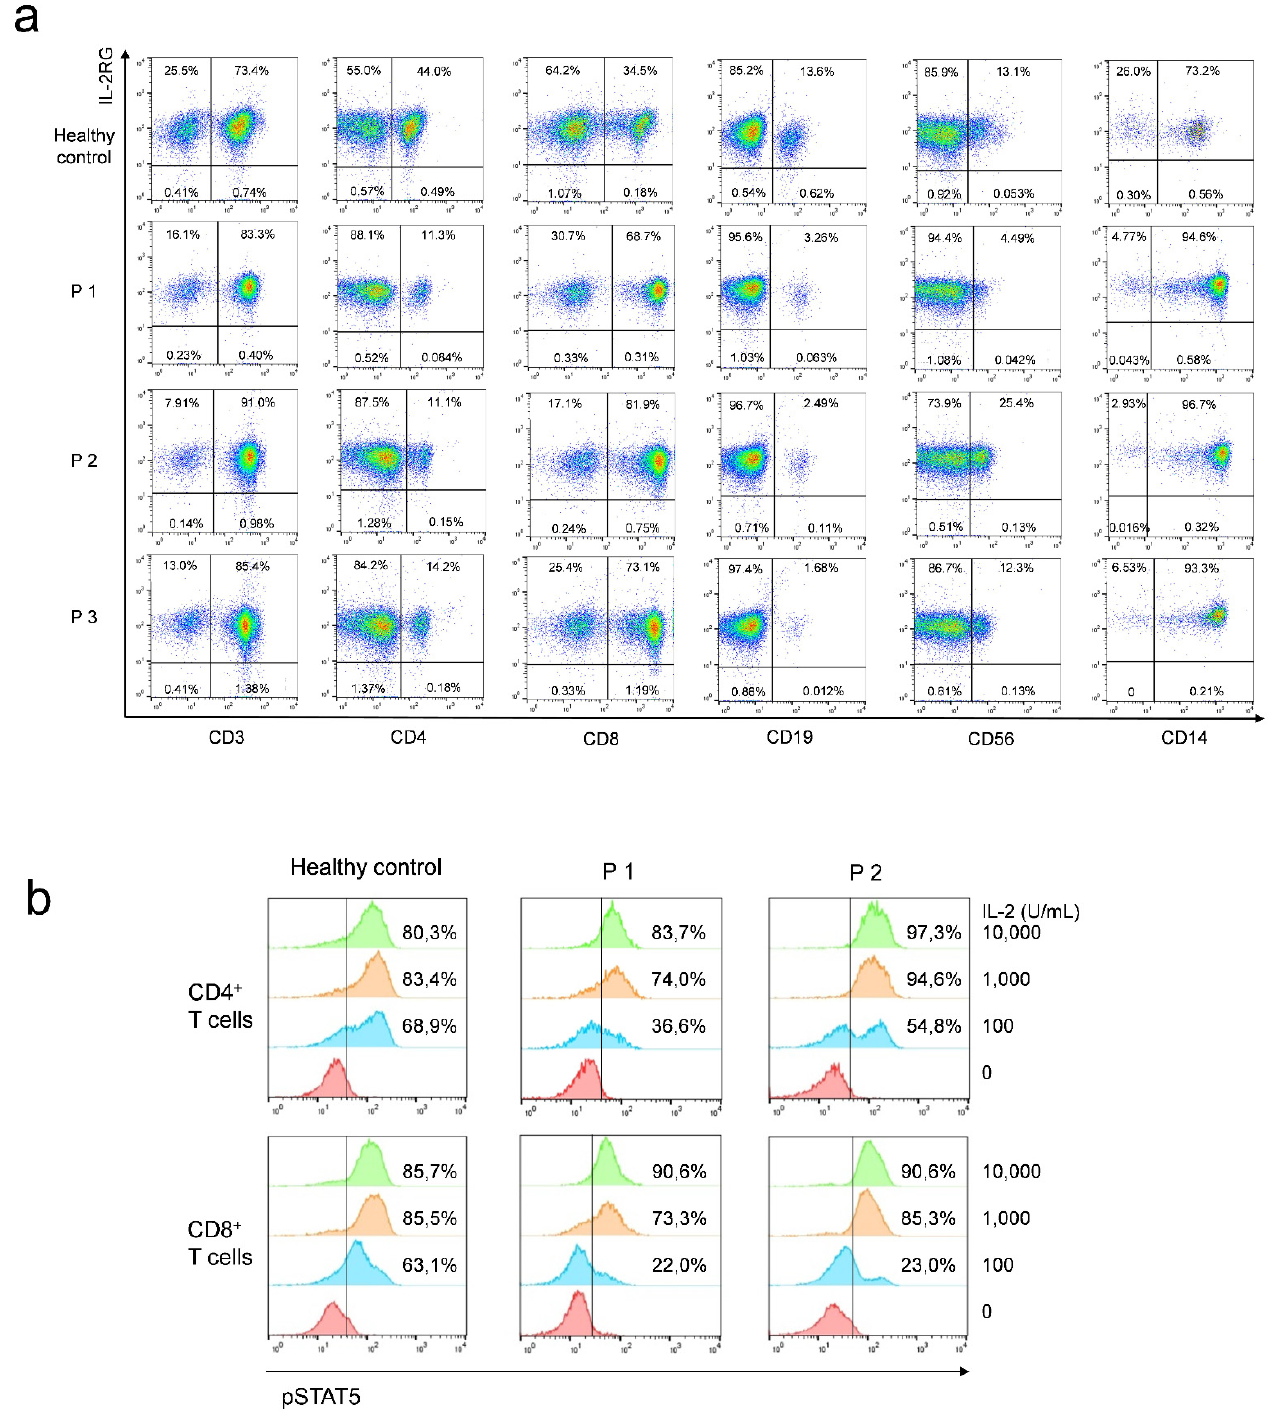
Figure 2. IL-2RG expression ( a ): Expression of IL-2RG was detected by flow cytometry. IL-2RG expression was normal in all three patients. PBMCs from the three patients and healthy controls ( n = 3, only one healthy donor is shown) were stained with CD132-PE antibody and the corresponding lymphocyte subpopulation antibodies. STAT5 phosphorylation ( b ): CD4 + and CD8 + T cells of P1 and P2 exhibited partial γ C signaling in response to stimulation with low concentrations of IL-2 (100 U/mL) compared to healthy donors ( p < 0.05 in CD8 + T cells). High concentrations (1000 and 10,000 U/mL) showed similar STAT5 phosphorylation to healthy controls.